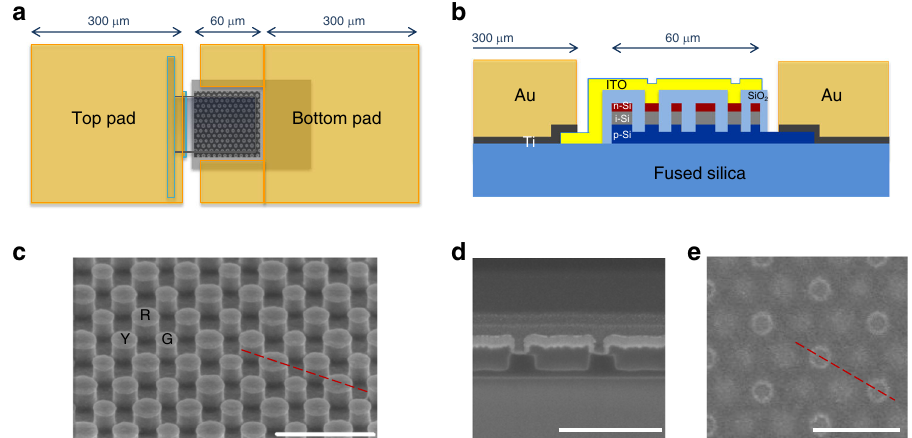
Fig. 2 Device layout of CMOS color sensors based on anti-Hermitian metasurfaces. a Top- and b side-view of color sensor device layout including electrical contacts. c Oblique view of scanning electron micrograph, just after nano patterning of PIN Si rods. d Side cross-section view and e top view of nanocylinder array, after SiO 2 gap- fi lling and ITO electrode deposition. The white scale bar corresponds to 500 nm in c – e . The diagonal red line in c and e indicates the cross-section presented in d